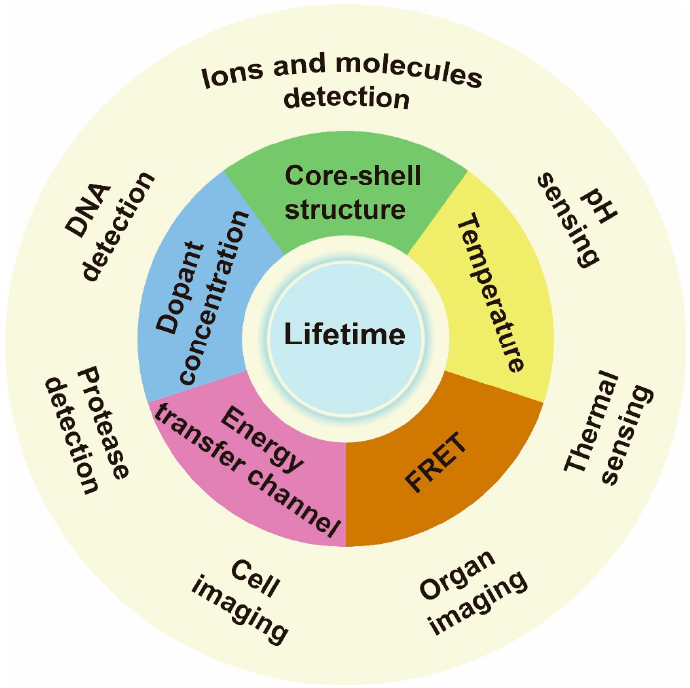
Figure 1. Schematic illustrations of lanthanide-doped nanoparticle lifetime regulation for biosens- ing. The approaches to regulating lifetime include varying core–shell structure, dopant concentra- tion, energy transfer channel, temperature and setting a fluorescence resonance energy transfer (FRET) system. The relevant applications include ions, molecules, DNA, protease, thermal and pH sensing, as well as cell labeling and organ